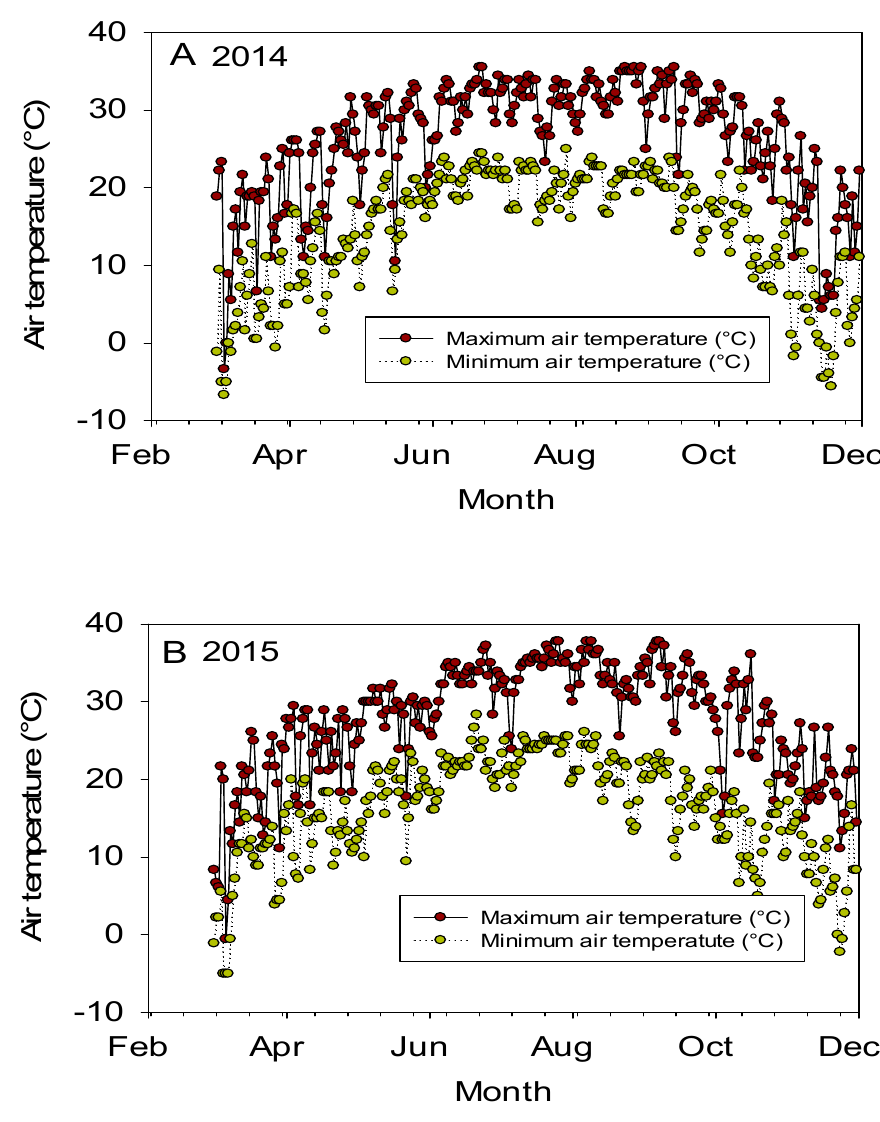
Figure 1. Air temperature (°C) during the growing season in 2014 ( A ) and 2015 ( B ). The experiment was conducted over 2014 and 2015 in Stoneville MS. Mississippi State University Extension, Delta Weather Center [40], verified on 01/30/2021.